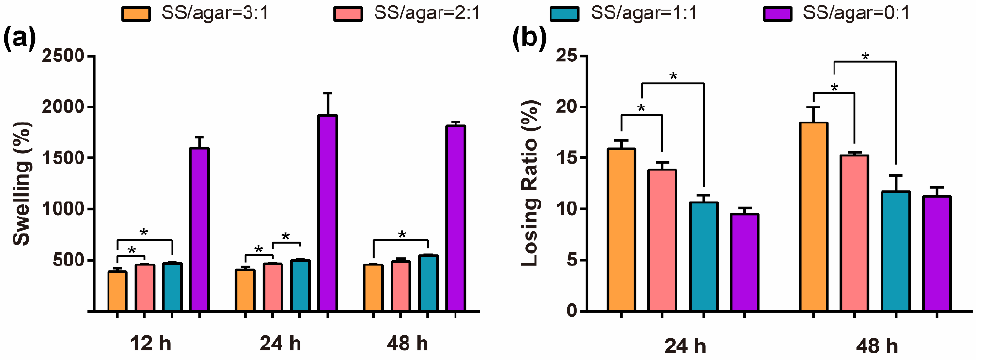
Figure 4. The swelling ( a ) and losing ratio ( b ) of the different SS/agar films. * indicates p < 0.05.